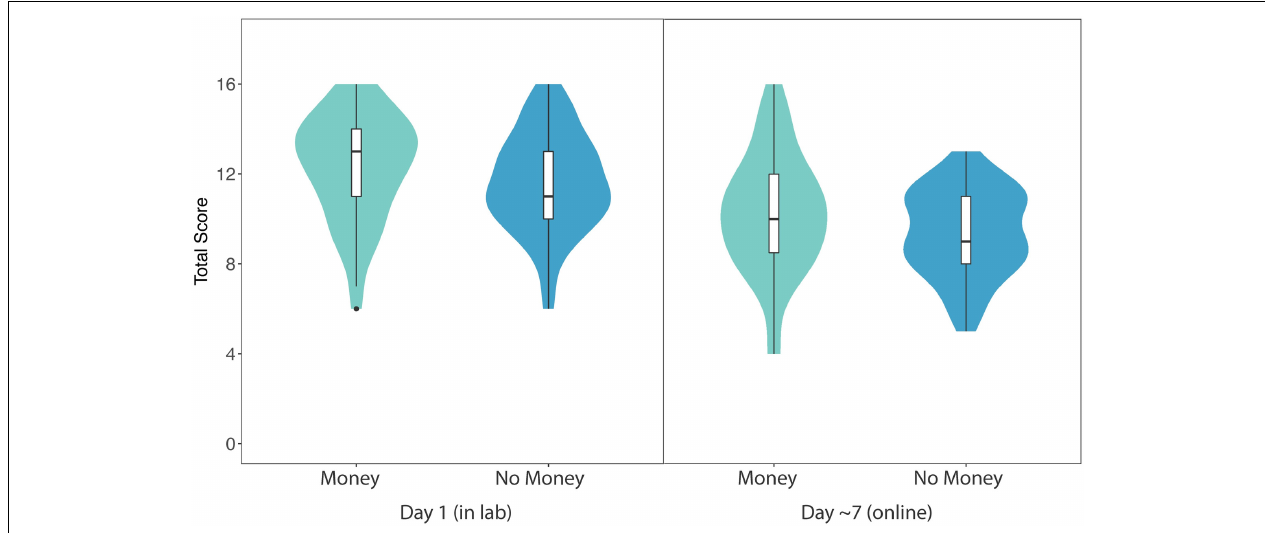
FIGURE 3 | Violin plots showing probability density of total score data (within-subjects) for Monetary and No Incentive videos in Experiment 2 (in lab and online follow-up). Maximum score was 16 points (8 questions per video). Horizontal lines show median average score, surrounded by boxes indicating the interquartile range. Results revealed a significant effect of incentive (Monetary compared to No Incentive) on total score in both the lab experiment and the online